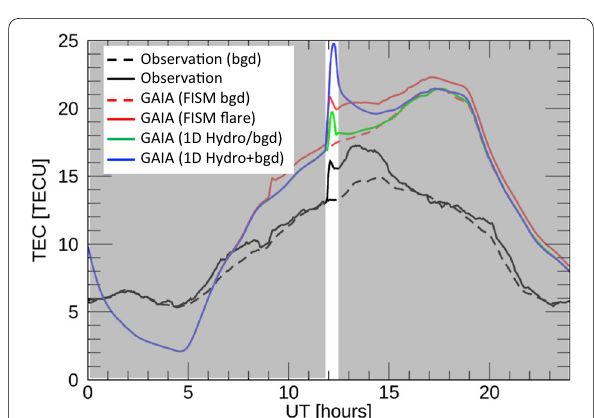
Fig. 9 Variation in TEC at 0°E and 44°N. The solid black line is the observed value (top-right panel in Fig. 4), and the dashed black line is the background of the observation (top-left panel in Fig. 4). The red dashed line, red solid line, green line, and blue line represent the calculation results of GAIA with background input (Fig. 7: Run1), “FISM” input (Fig. 7: Run2), “1D Hydro/bgd” input (Fig. 7: Run3), and “1D Hydro bgd” input (Fig. 7: Run4), respectively. Gray regions have no + 1D Hydro model data